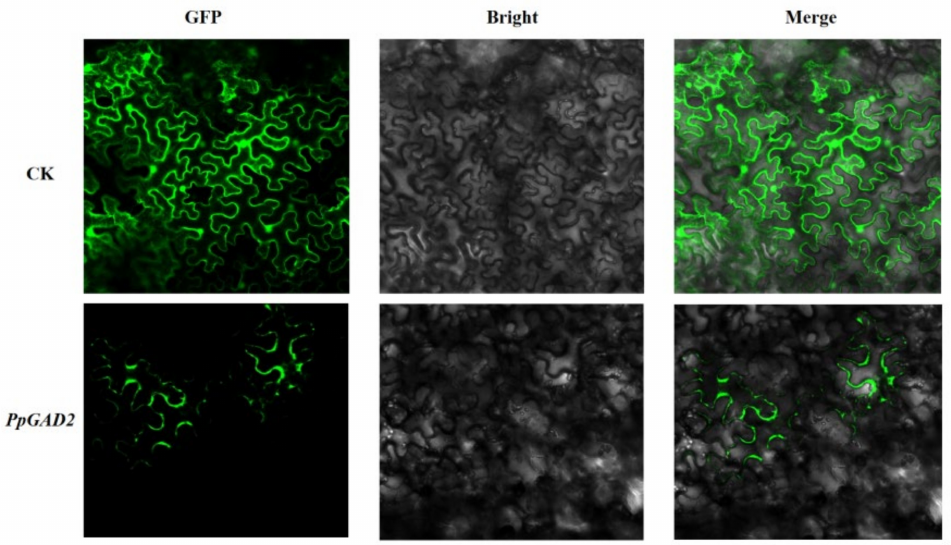
Figure 4. Subcellular localization of PpGAD2 in tobacco leaves. The images from left to right are green fluorescent signals from GFP, bright fields, and merged, respectively. Leaves transformed with a noncoding sequence vector were used as the control